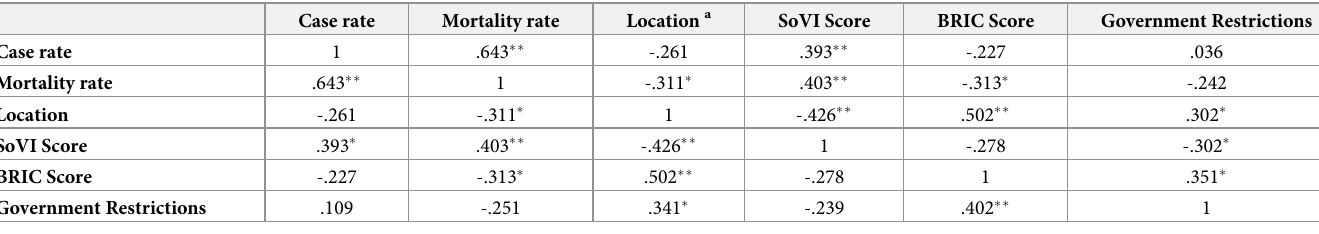
Table 3. Correlates of COVID-19 case rates and mortality